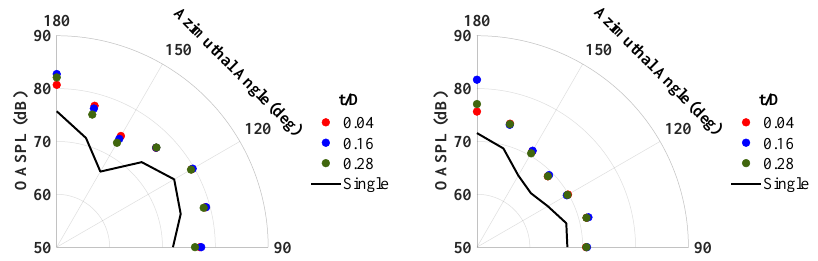
Figure A2. Azimuthal directivity: ( left ) tonal noise; ( right ) broadband noise. The modification in the shape of the curves with increasing rpm is mainly attributed to the behavior of the tonal noise, dominated by the trend of the first BPF, which suggests the presence of considerable installation effects. Being at static thrust conditions, a higher rotational speed results in more air being sucked in by the rotor; asymmetries due to the experimental set up in the upstream lead to a visible variation in the directivity